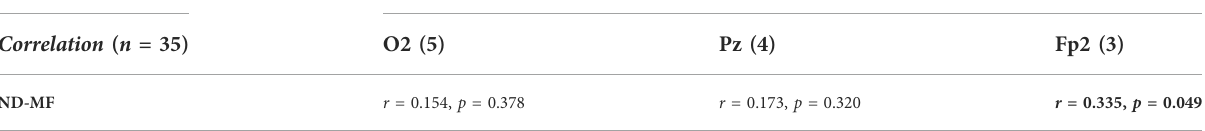
TABLE4Pearson ’ scorrelationbetweenchangesinsupra-thresholdinter-regionalcouplingofspectralbands/key-nodesandstabilometerdynamics. Pearson ’ s correlation between increases in supra-threshold inter-regional functional coupling of key nodes (O2, Pz, and Fp2) of alpha-band and postural sway dynamics due to stroboscopic vision. The numbers within parentheses are the edge number of each key node. The black-bolded and grey-bolded fonts in the shaded areas indicate signi fi cant and marginally-signi fi cant correlations of regional activity and postural sway dynamics,